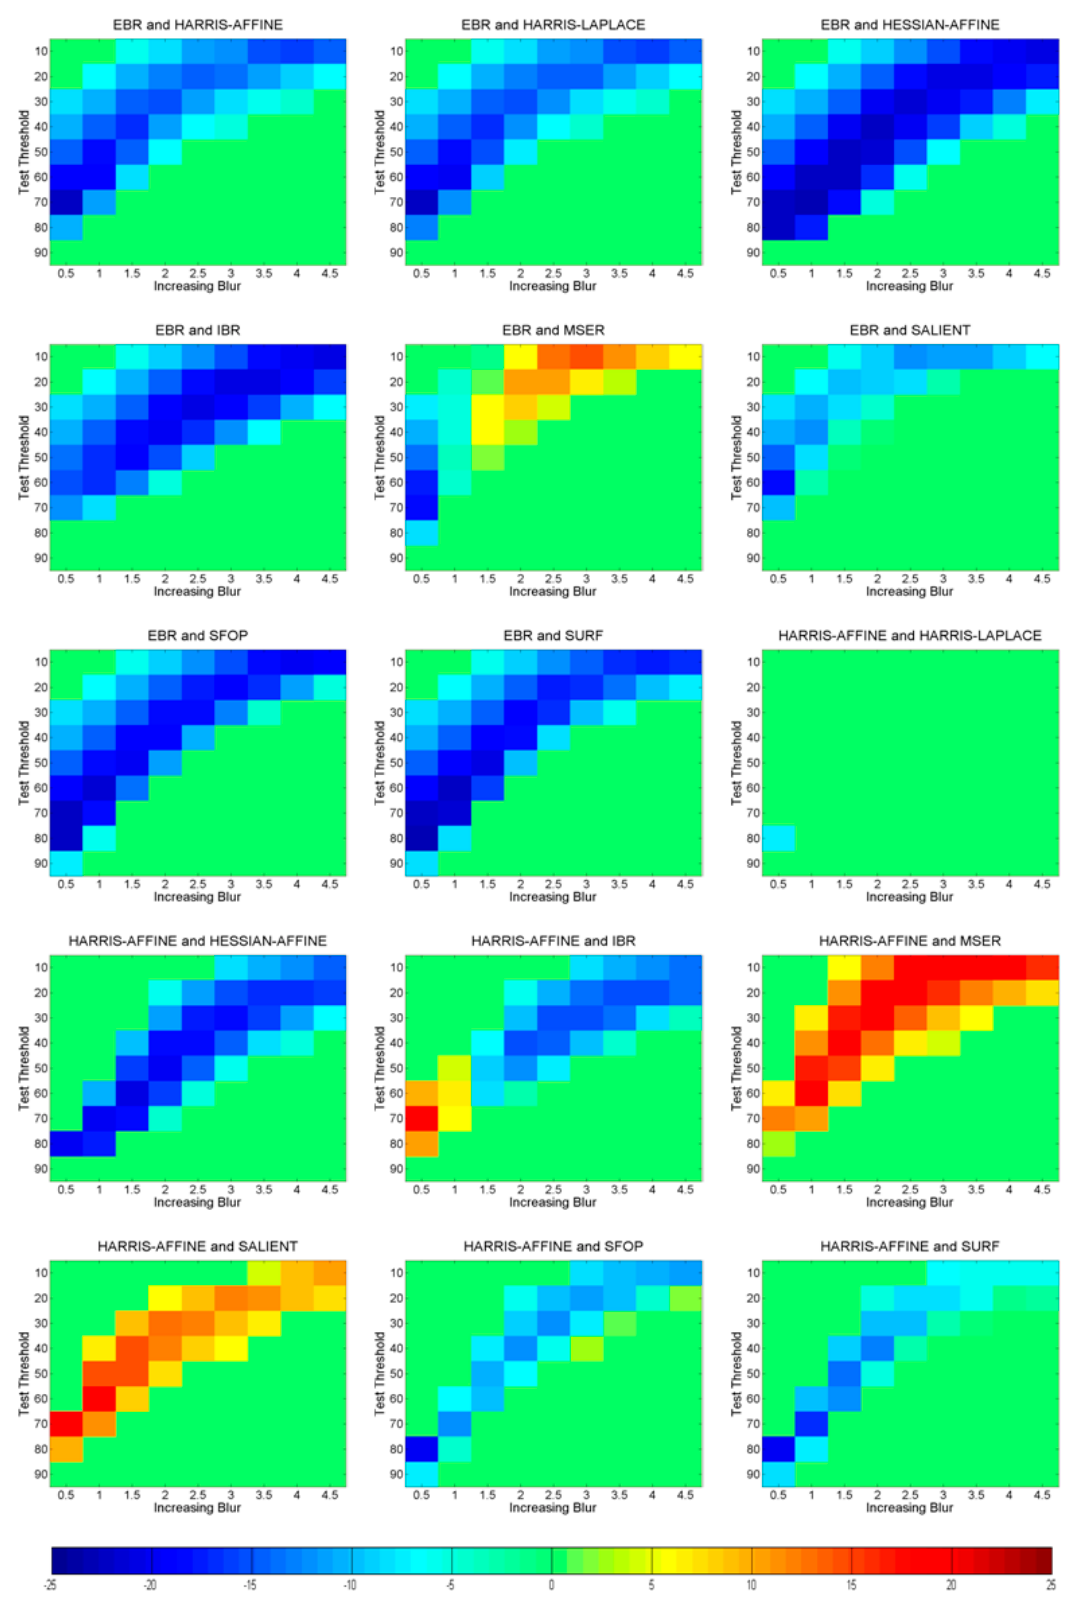
Figure 14. Results of blur changes for (EBR and Harris-Affine with the other detectors showing Z -scores obtained; positive Z -scores indicate that the first detector is better than the second whereas the negative values show the converse.